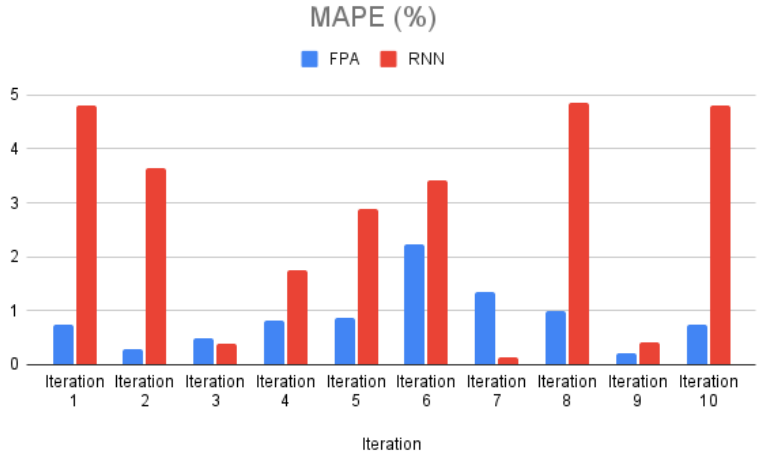
Figure 8. Bar chart of MAPE for short-term forecasting in testing data.